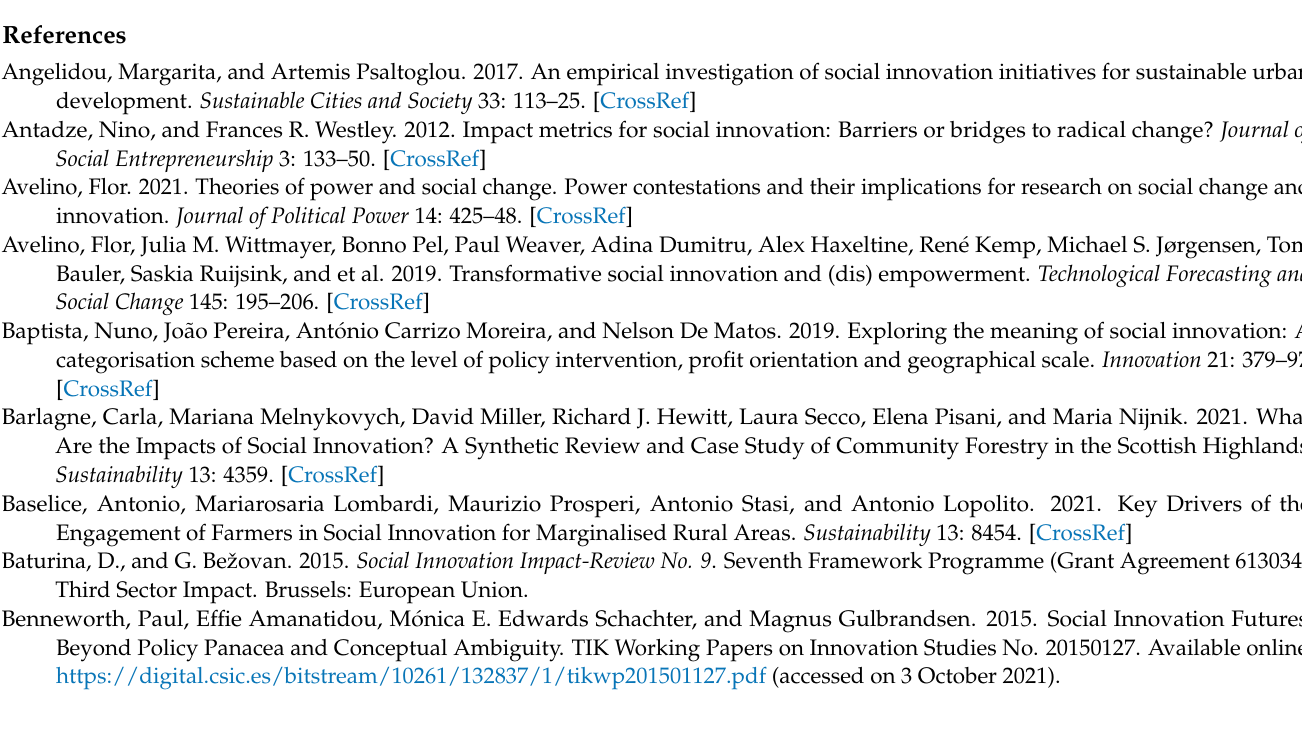
The NUTS classification (Nomenclature of territorial units for statistics) is a hierarchical system for dividing up the economic territory of the EU and the UK. For more info, please see: https://ec.europa.eu/eurostat/web/nuts/background (accessed on 15 March